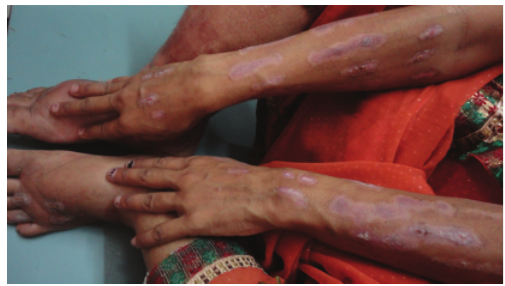
Figure 1: Dermatitis artefacta lesions on the upper limbs.